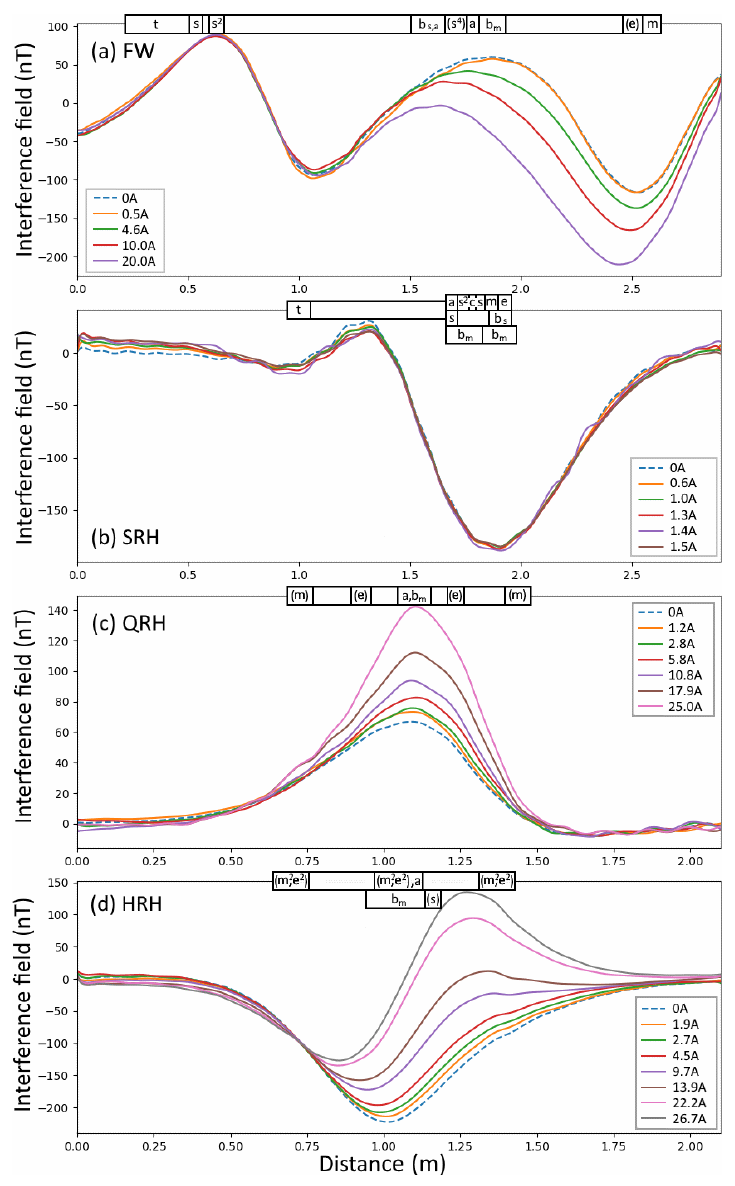
Figure 8. The interference profiles for each UAS oriented to the north at different motor current draws. Profiles have been filtered using a 0.25Hz low-pass filter. A profile was calculated for 0A (dashed profile). The location of the UAS system components are marked on the top border of each profile set. Components are denoted as “a” – avionics controller/receiver, “m” – motor, “s” – servo, “t” – tail, “c” – SRH centre mast, “ b m ” – motor battery, “ b s ” – servo battery, “ b a ” – the autopilot battery, and “e” – ESC. Parentheses indicate that components are located laterally with respect to the profile